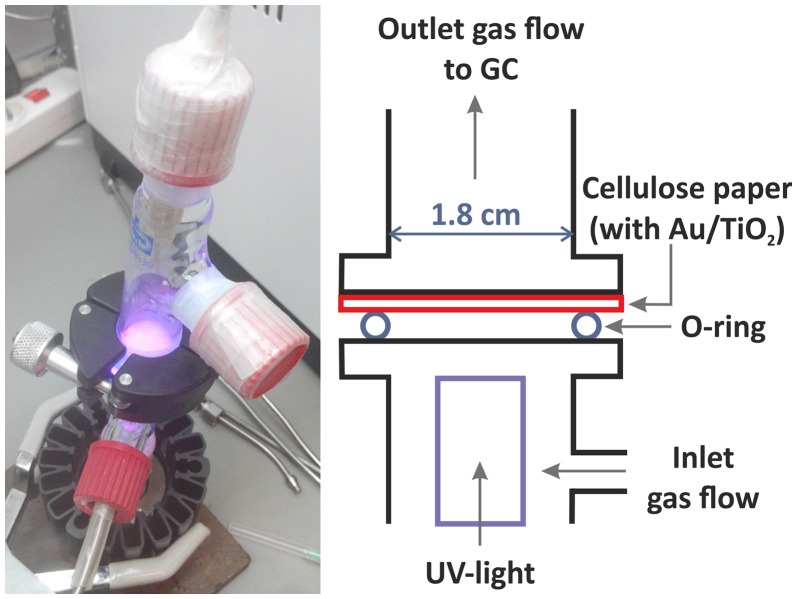
Image and scheme of the photoreactor. The UV-light LED irradiates the sample from below.